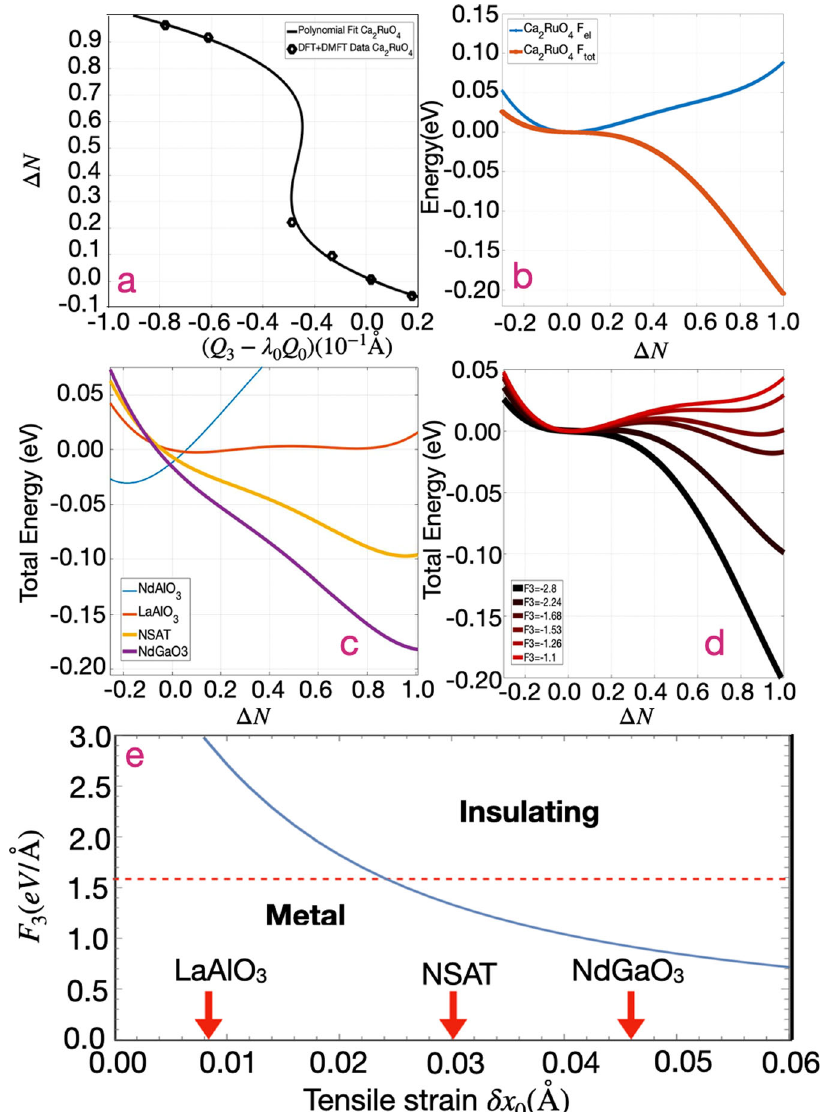
Fig. 8 Equation of state fi t for bulk Ca 2 RuO 4 , the resulting energy, and energy as a function of epitaxial strain. a Electronic disproportionation as a function of structural disproportionation Δ N ( Q ) from 5 (heavy black points) and polynomial fi t (solid line) used for the equation of state. b Correlated electron free energy, and total free energy as a function of the electronic disproportionation order parameter characterizing the orbital polarization: F el ( Δ N ) and F total ( Δ N ) for bulk Ca 2 RuO 4 . c Total energy plotted against orbital disproportionation Δ N for materials grown on four substrates indicated in the legend (NSAT is Nd 0.4 Sr 0.6 Al 0.7 Ta 0.3 O 3 ) which provide different strains relative to the metallic phase of Ca 2 RuO 4 . For compressive strain (NdAlO 3 ), the material is always metallic and the orbital polarization has the opposite sign from the insulating state. d Total free energy versus electronic disproportionation Δ N : F total ( Δ N ) computed for bulk Ca 2 RuO 4 different values of the linear coupling term F 3 . e Phase diagram of epitaxially constrained Ca 2 RuO 4 in plane of tensile strain (de fi ned as difference of mean in-plane Ru – O bond length from value in the high temperature structure) in Å and electron-lattice coupling parameter F 3 . Red dashed line: value of F 3 at which metal insulator transition occurs in bulk system. Arrows (red on line) indicate strain imposed by epitaxial